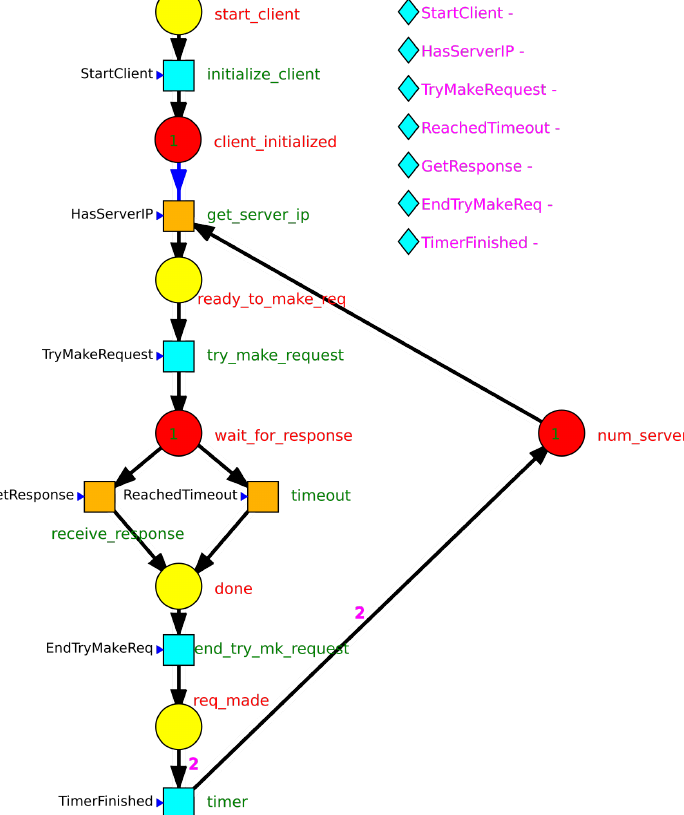
Figure 13. The IOPT-net model of the controller of the NWBC